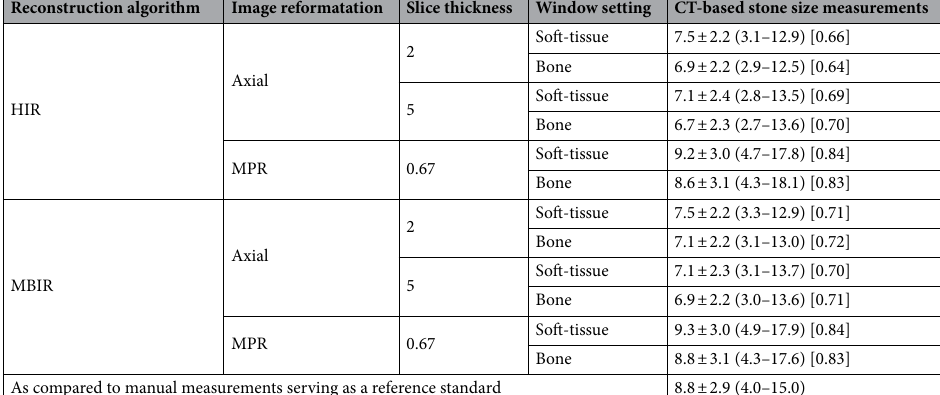
Table 2. Kidney stone size measurements regarding different reconstruction algorithms, image reformatations, slice thicknesses and window settings indicated as mean ± standard deviation (range) [Pearson correlation coefficient]. HIR hybrid-iterative reconstruction algorithm, MBIR model-based iterative reconstruction algorithm, MPR multiplanar